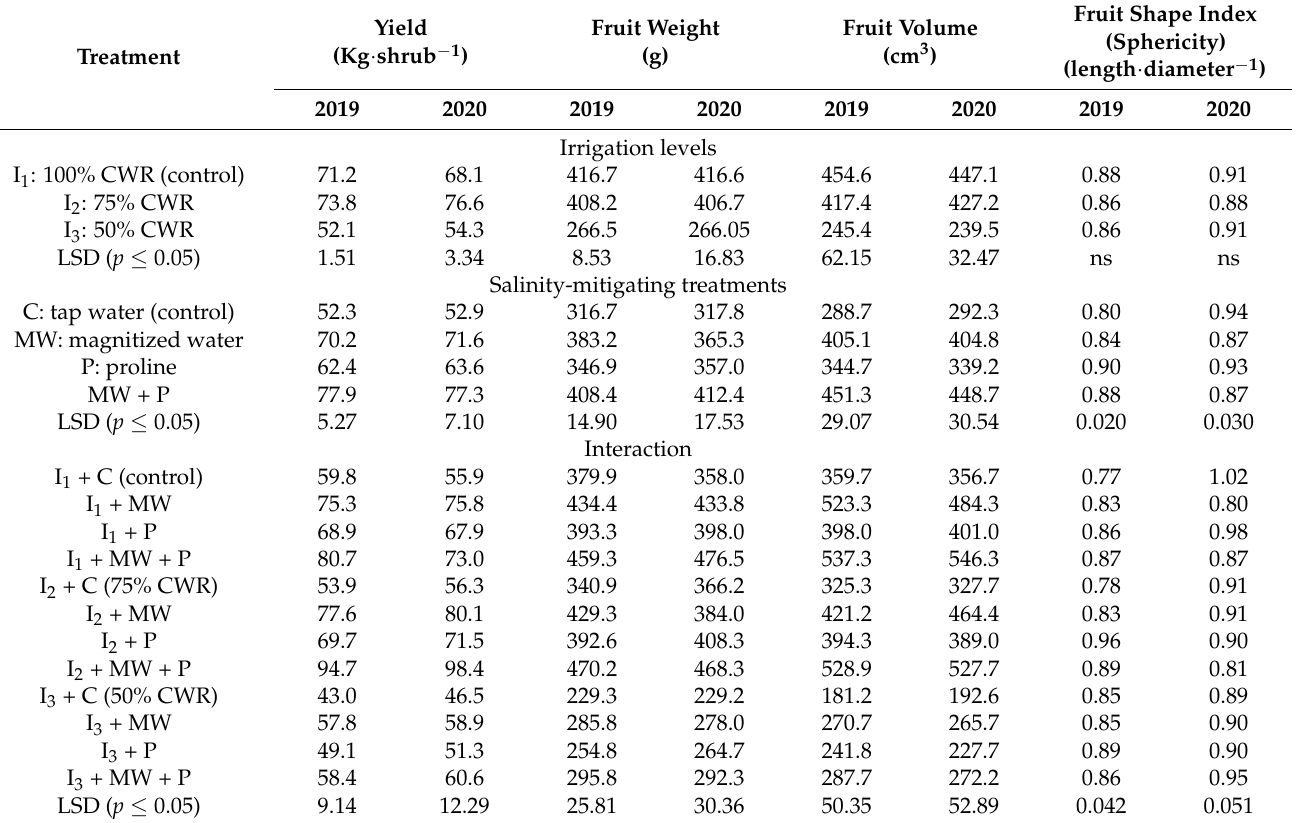
Table 6. Effect of MW, P, and MW + P on yield and fruit physical characteristics of “Taifi” pomegranate shrubs grown under different irrigation regimes (I 1 , I 2 , and I 3 ), based on CWR, during the 2019 and 2020